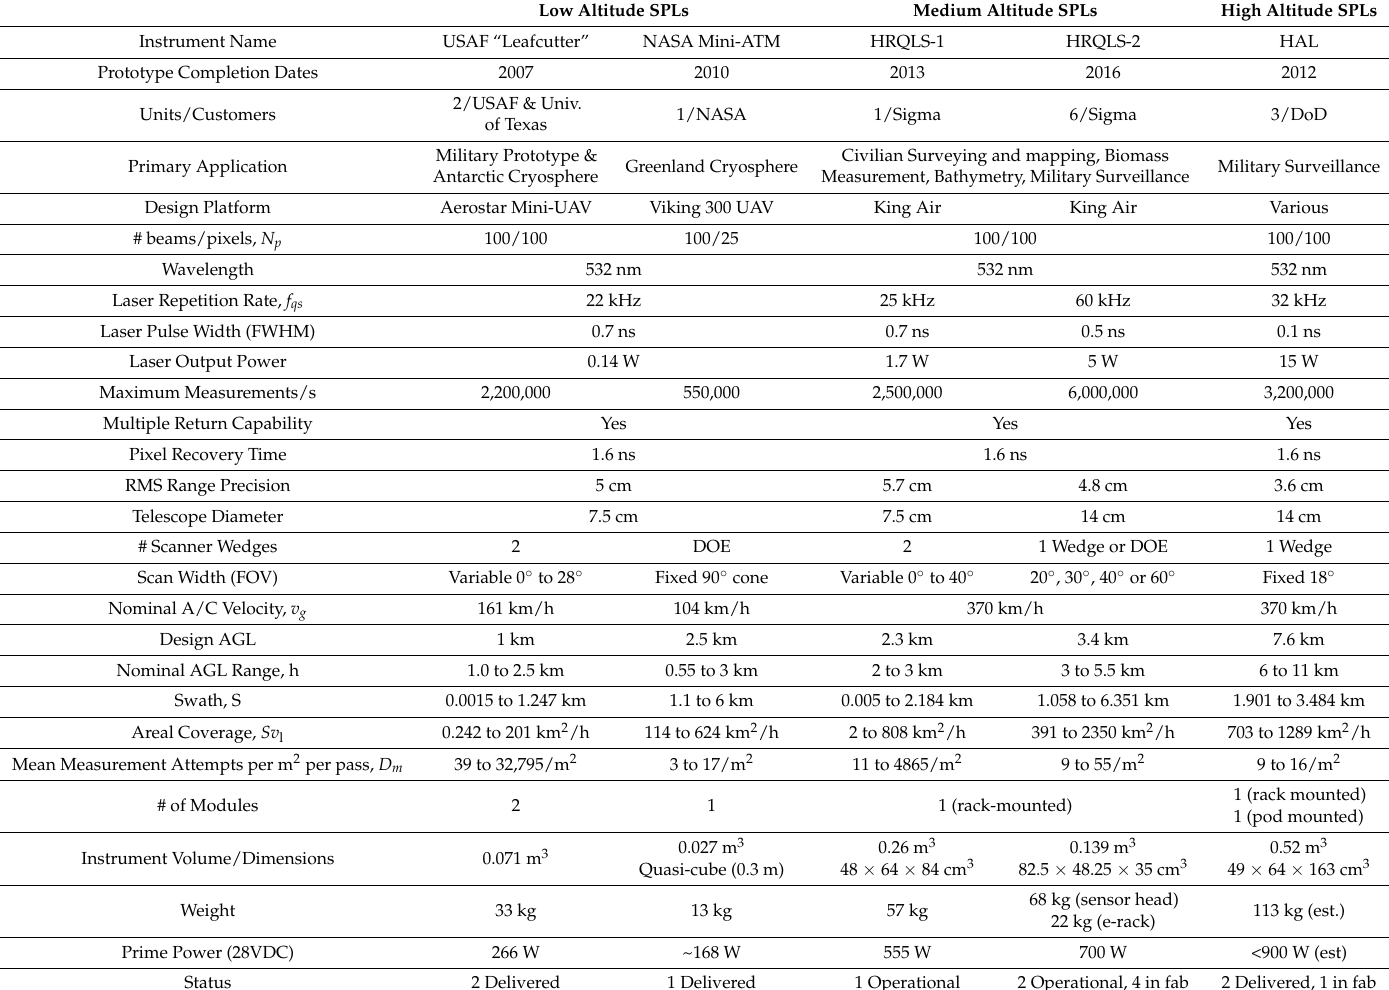
Table 1. Summary table of design and performance properties for the current suite of Sigma scanning SPL